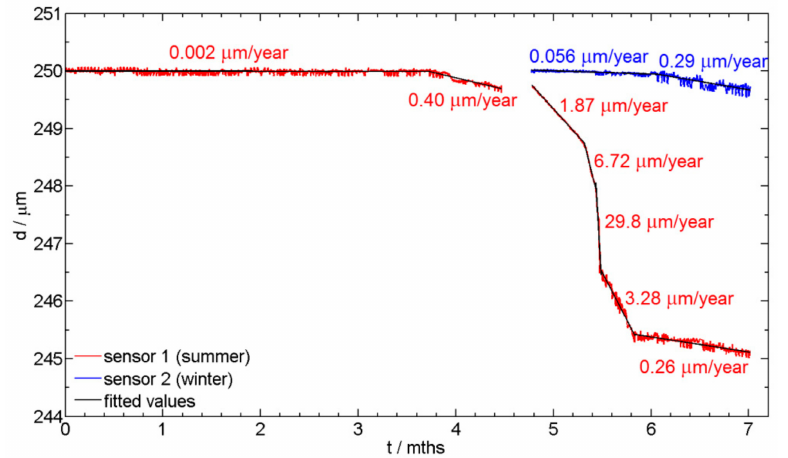
Figure 6. Values of the average corrosion rates in the di ff erent sections of the measured data of sensor 1 (summer) and sensor 2 (winter).